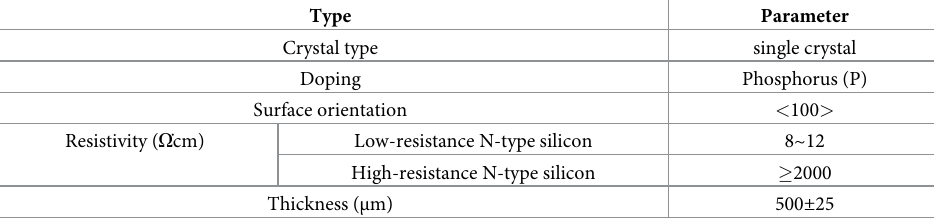
Table 1. Basic specifications of single crystal low resistance (high resistance) N-type